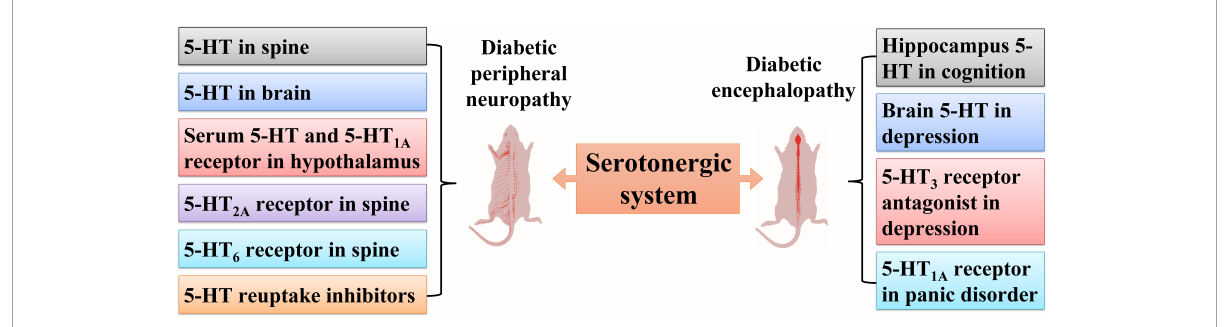
FIGURE2 Roles of the serotonergic system in diabetic peripheral neuropathy and diabetic encephalopathy. Serotonergic systems involving 5-HT in serum, spine, brain, the 5-HT 2 A receptor and 5-HT 6 receptor in the spine, and the 5-HT 1 A receptor in the hypothalamus participate in diabetic peripheral neuropathy. The serotonergic system is also involved in diabetic encephalopathy, including hippocampal 5-HT in cognition dysfunction, brain 5-HT in depression, 5-HT 3 receptor antagonists in depression, and the 5-HT 1 A receptor in panic